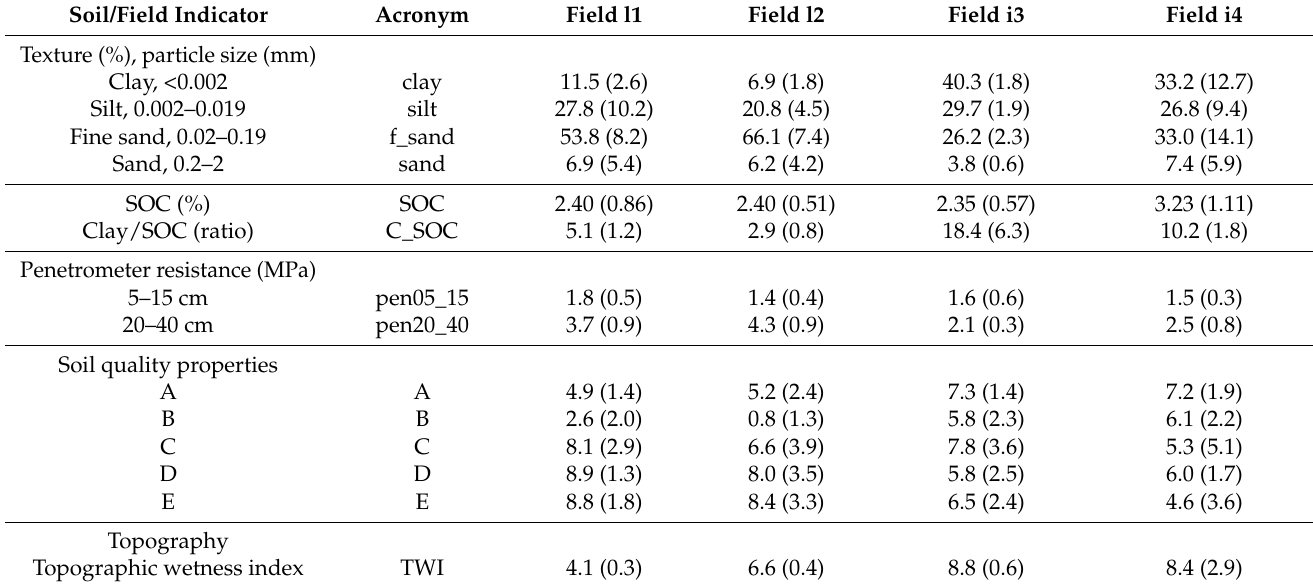
Table 3. Overview of soil/field indicators. Soil texture and soil organic carbon content (SOC) in a layer of 0–20 cm. The estimates for the topsoil and upper subsoil quality properties (scale 0–10, indicating worst to excellent), prepared utilizing a soil quality assessment commonly used in Finland [28]: A = topsoil biological indicators, B = subsoil macroporosity, C = compacted layers in soil profile, D = topsoil structure, E = subsoil structure, TWI = topographic wetness index. Mean of 10–12 samples for soil texture, SOC, and penetration resistance, and of 8–10 samples for soil quality properties in all fields; values in parentheses indicate standard deviations